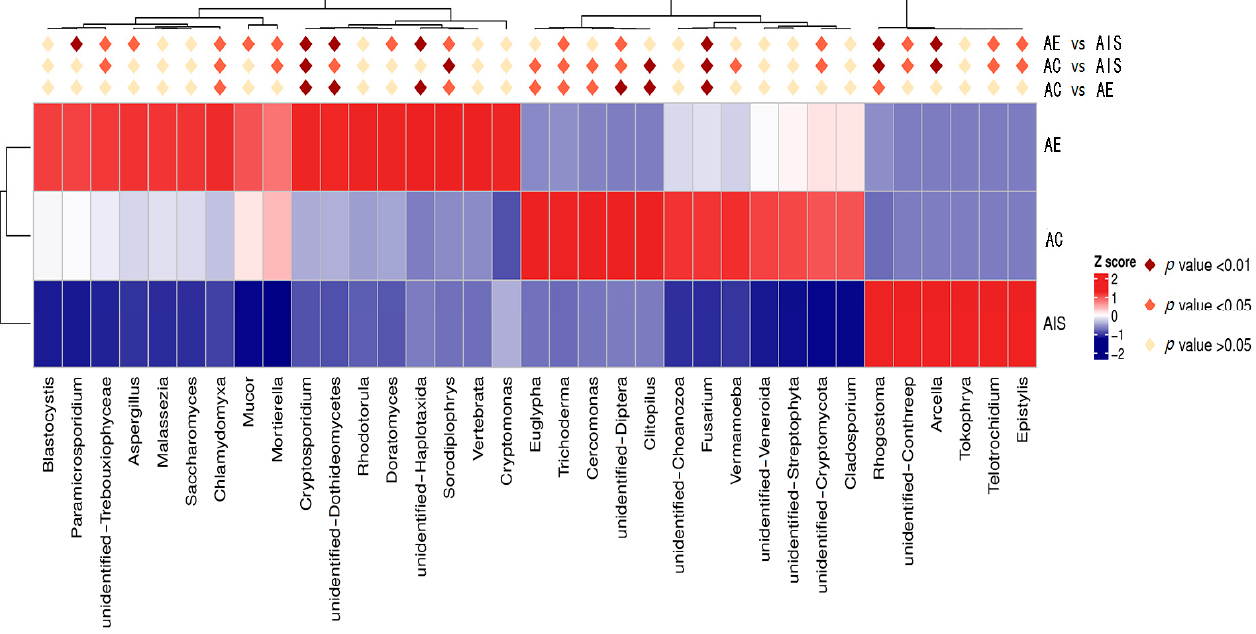
Figure 5. Heatmap of dominant eukaryotic genus and significant differences among initial sludge (AIS) and final products of control (AC) and vermicompost (AE).